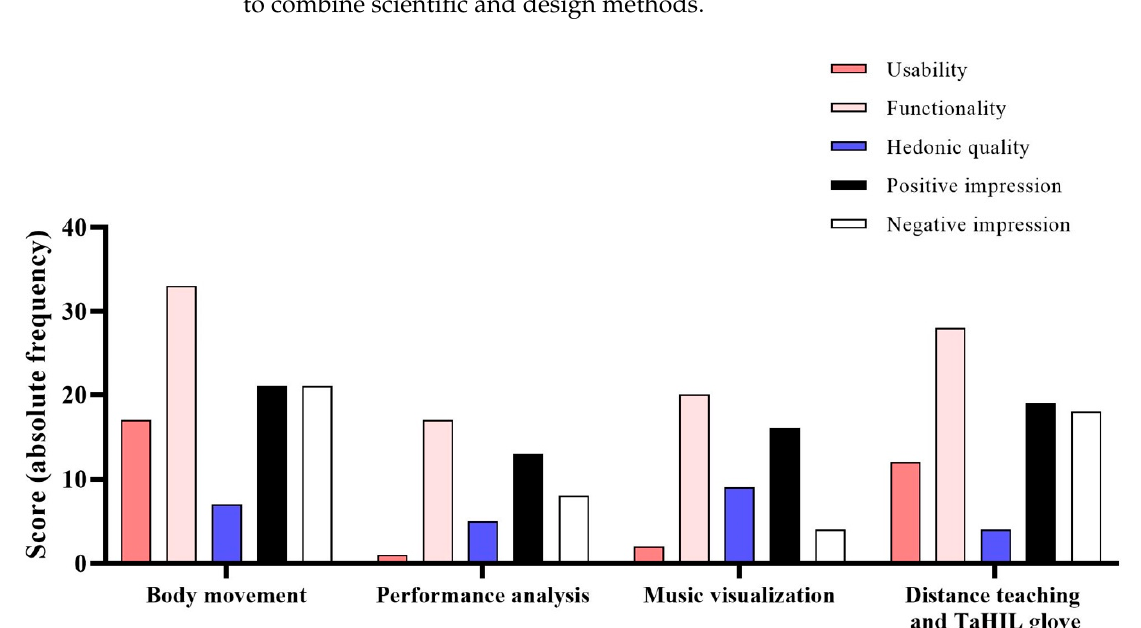
Figure 5. Hedonic, pragmatic, and sentiment metrics for the three scenarios. Usability and functionality scores describe pragmatic metrics. The sentiment scores show if the scenario had been discussed in a negative or positive way (positive and negative impression). The scenarios body movement, performance analysis, and music visualization were described in this paper and used as prompts during the interviews. The scenario distance teaching and TaHIL gloves developed dynamically during the interviews and was added to the analysis.